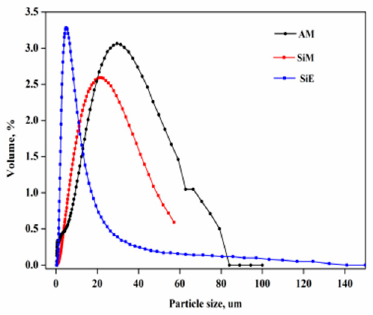
Figure 5. Diameter distribution of AM, SiM, and SiE. Table 2. Specific surface area and D (50) of AM, SiM, and SiE.